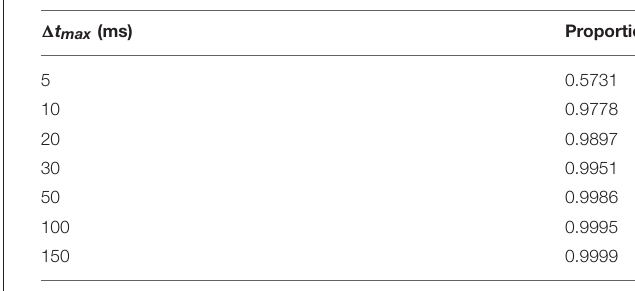
TABLE 2 | Shown are the proportion of annotated-detected onset pairs detected at each threshold